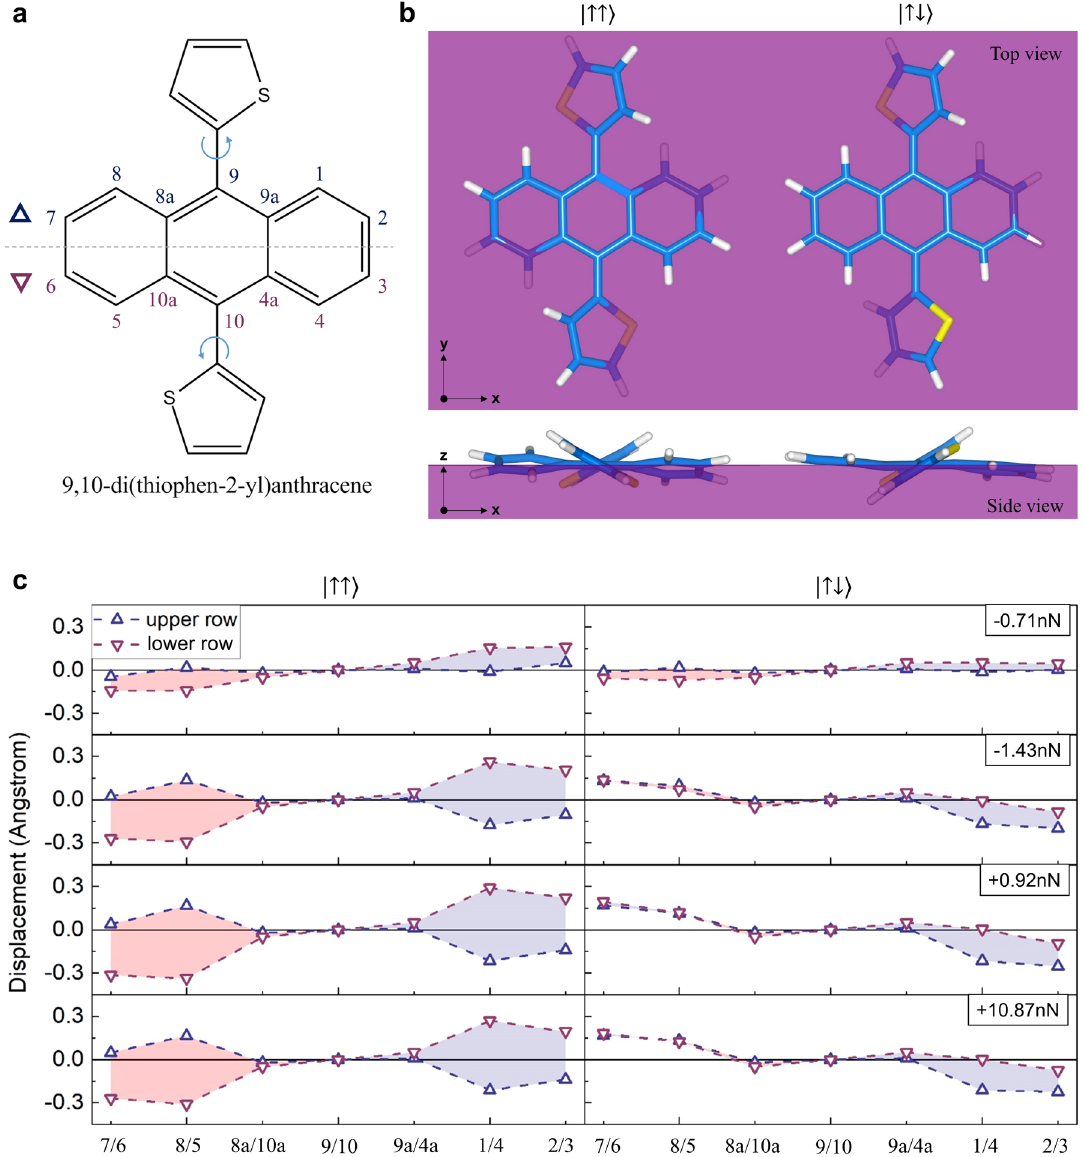
Fig. 4 Structural insights for electronic energy difference in polar and non-polar state. a Structure and atomic positions of MR2 . b Conformation of MR2 in ""j i and "#j i states under 0.92 nN of mechanical force. To illustrate the distortion of MR2 , stick representation of the molecule is placed in purple “ ink ” . The level of the “ ink ” crosses the central plane the molecular and structures lower than this level is immersed. c Displacement of carbon atoms in z direction from central plane corresponding to positions in a under directional mechanical loads for ""j i and "#j i states. The color in background indicates the difference in displacements of corresponding atom pairs: red for positive and blue for